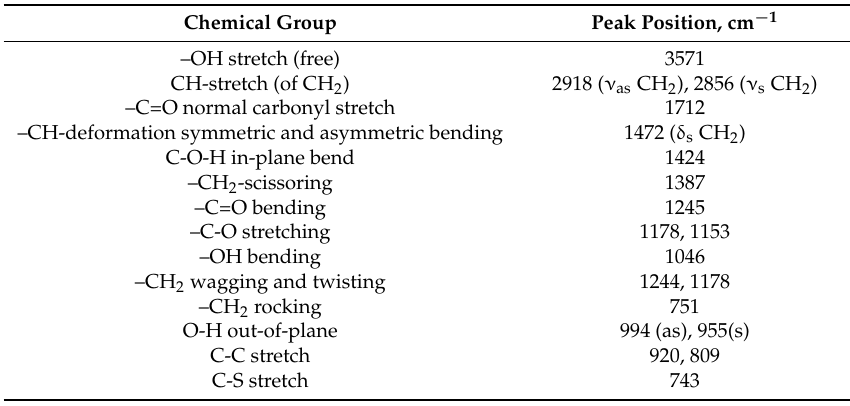
Table 12. FT-IR data for PBS and P(BSxTDGSy)